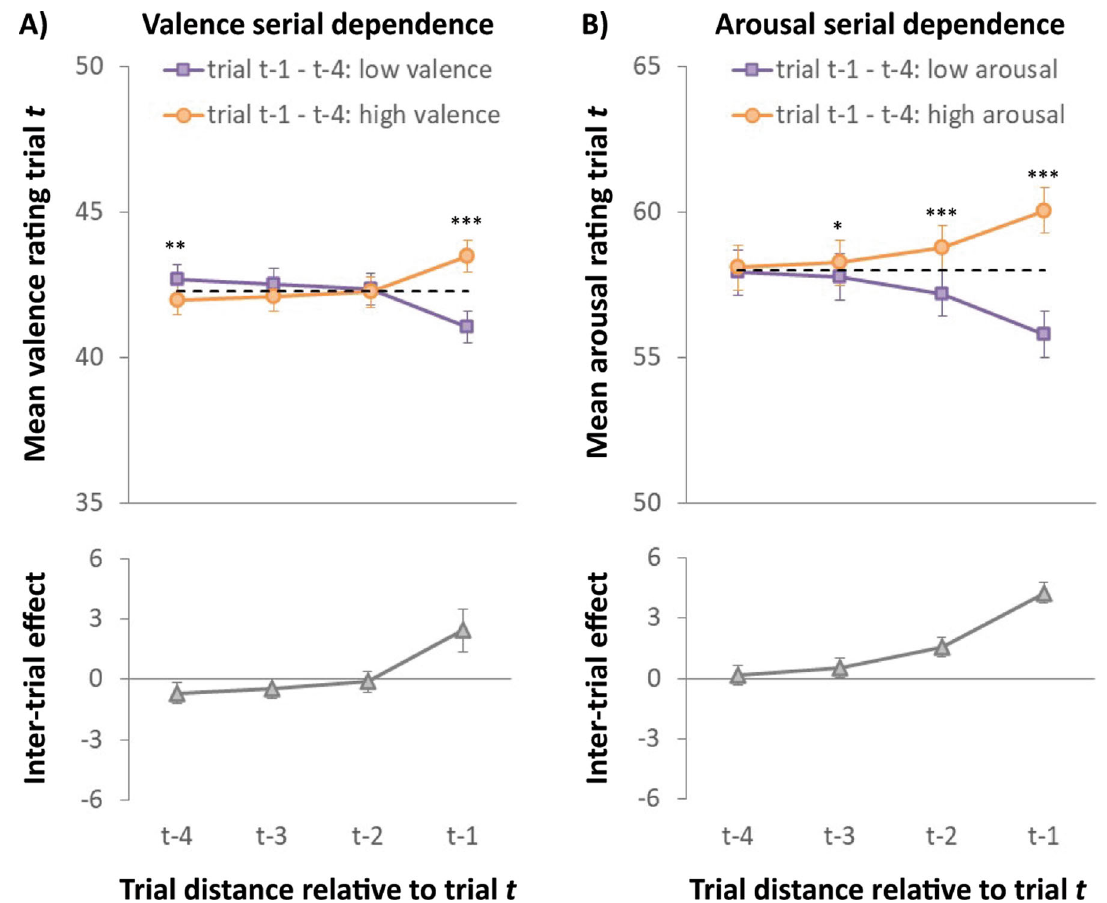
Fig. 2 Sequential effects for food image processing. A Upper panel: Mean valence rating (on a 100-point scale) on trial t as a function of the valence rating (low: purple squares, or high: orange circles) on trial t − 1 back to trial t − 4. The dotted line indicates the group mean valence rating. Lower panel: Valence inter-trial effect (i.e., the difference between the high and low valence rating in the upper panel) as a function of the trial distance relative to the current trial t . B Upper panel: Mean arousal rating on trial t as a function of the arousal rating (low: purple squares, or high: orange circles) on trial t − 1 back to trial t − 4. The dotted line indicates the group mean arousal rating. Lower panel: Arousal inter-trial effect (i.e., the difference between the high and low arousal rating in the upper panel) as a function of the trial distance relative to the current trial t . Error bars represent the ±2 standard error of the mean. Signi fi cance levels: * p < 0.05, ** p < 0.01, and *** p <